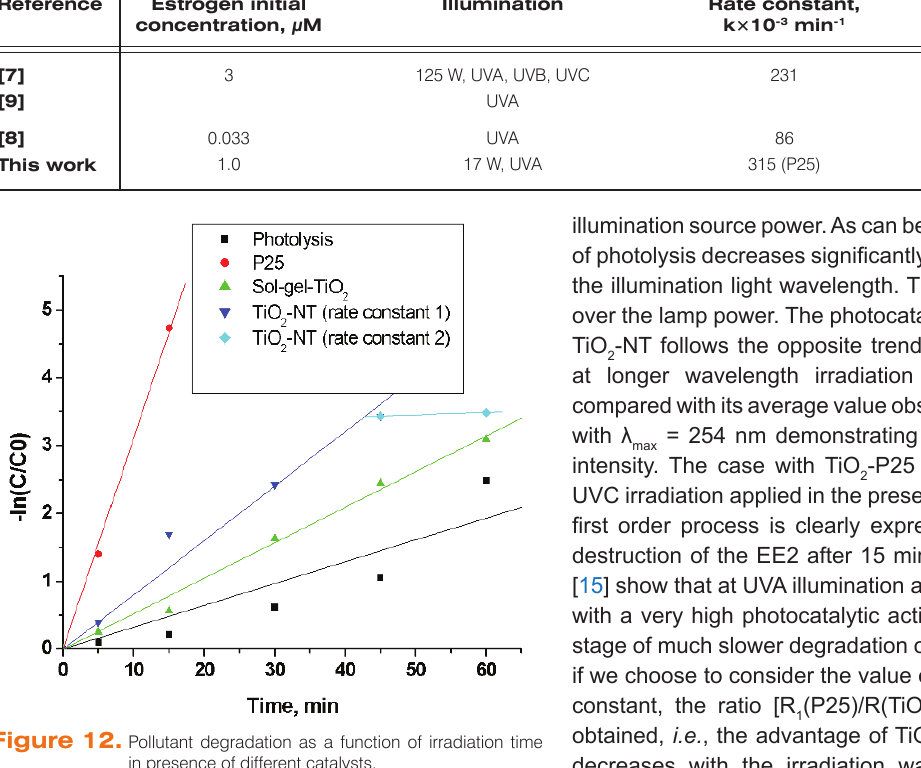
Figure 12. Pollutant degradation as a function of irradiation time in presence of different catalysts.